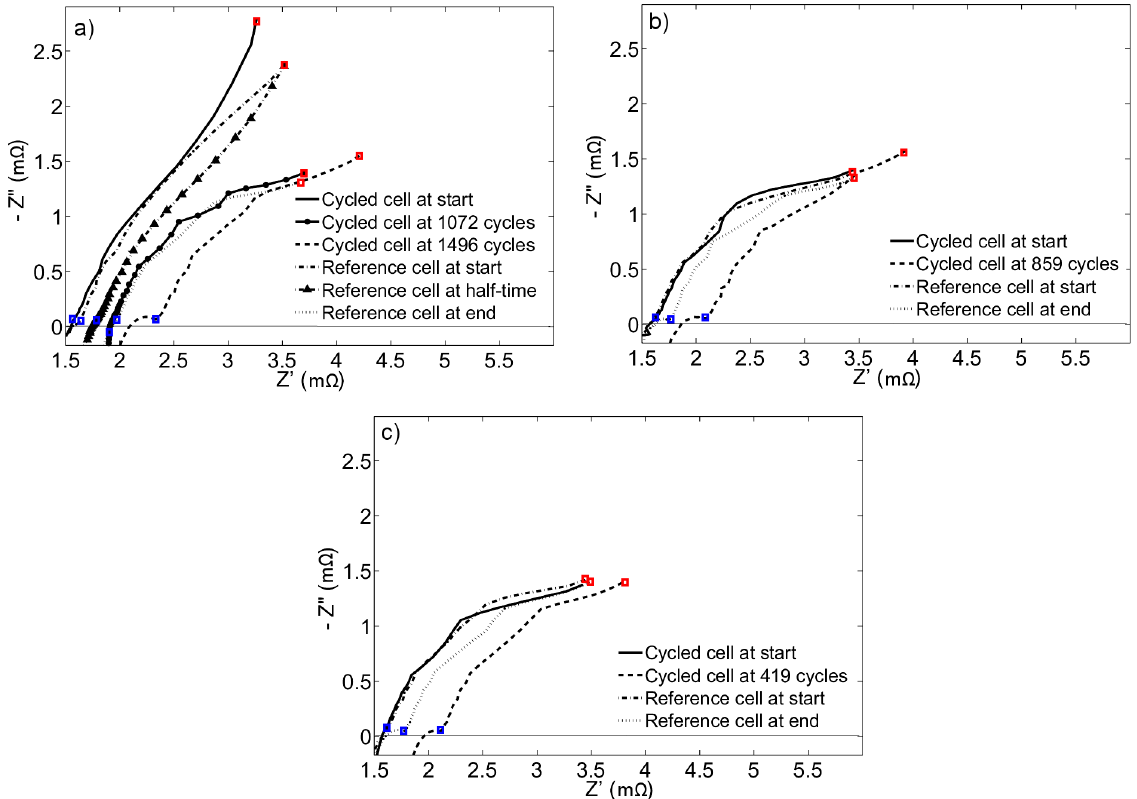
Figure 7. Nyquist plots at SOC 50% and 23 °C for both cycled and calendar-aged cells. Blue square markings represent 1 Hz and red represents 0.01 Hz. ( a ) Cells from Truck 1; ( b ) cells from Truck 2; ( c ) cells from Truck